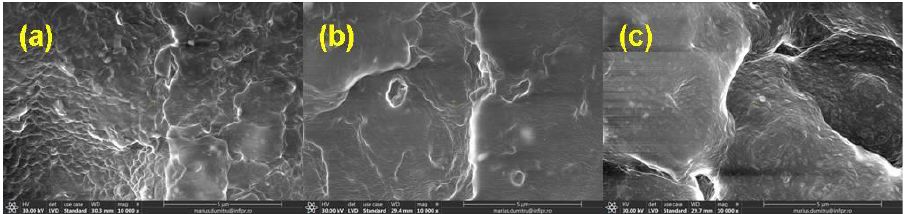
Figure 7. SEM micrographs of mixture B at magnification of 10,000: ( a ) non-irradiated and irradiated at ( b ) 150 kGy and ( c ) 450 kGy.